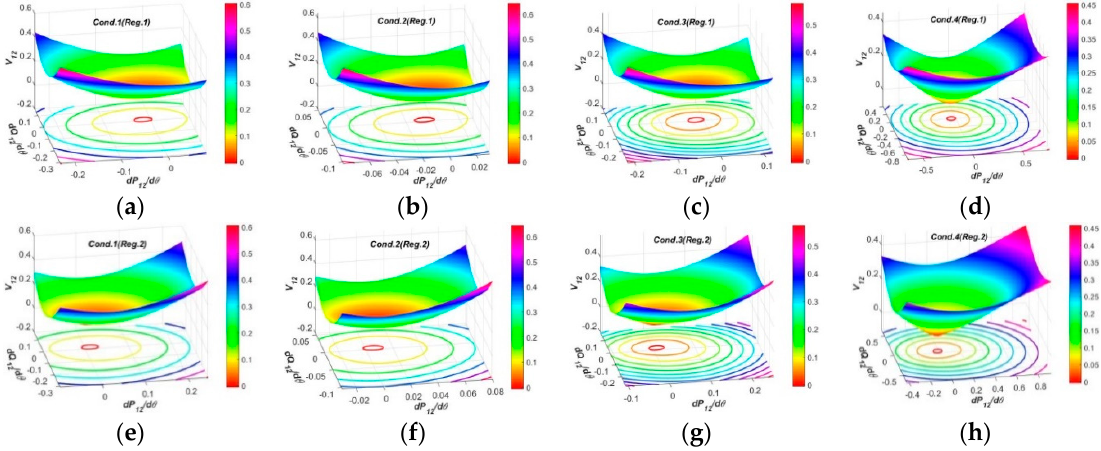
Figure 5. Spatial surfaces of PFG to CIV2 at SCP2 in spaces: ( a – d ) Spatial surfaces of PFG to CIV2 by Reg.1 mode of OSIV in four operation conditions; ( e – h ) Spatial surfaces of PFG to CIV2 by Reg.2 mode of OSIV in four operation conditions.